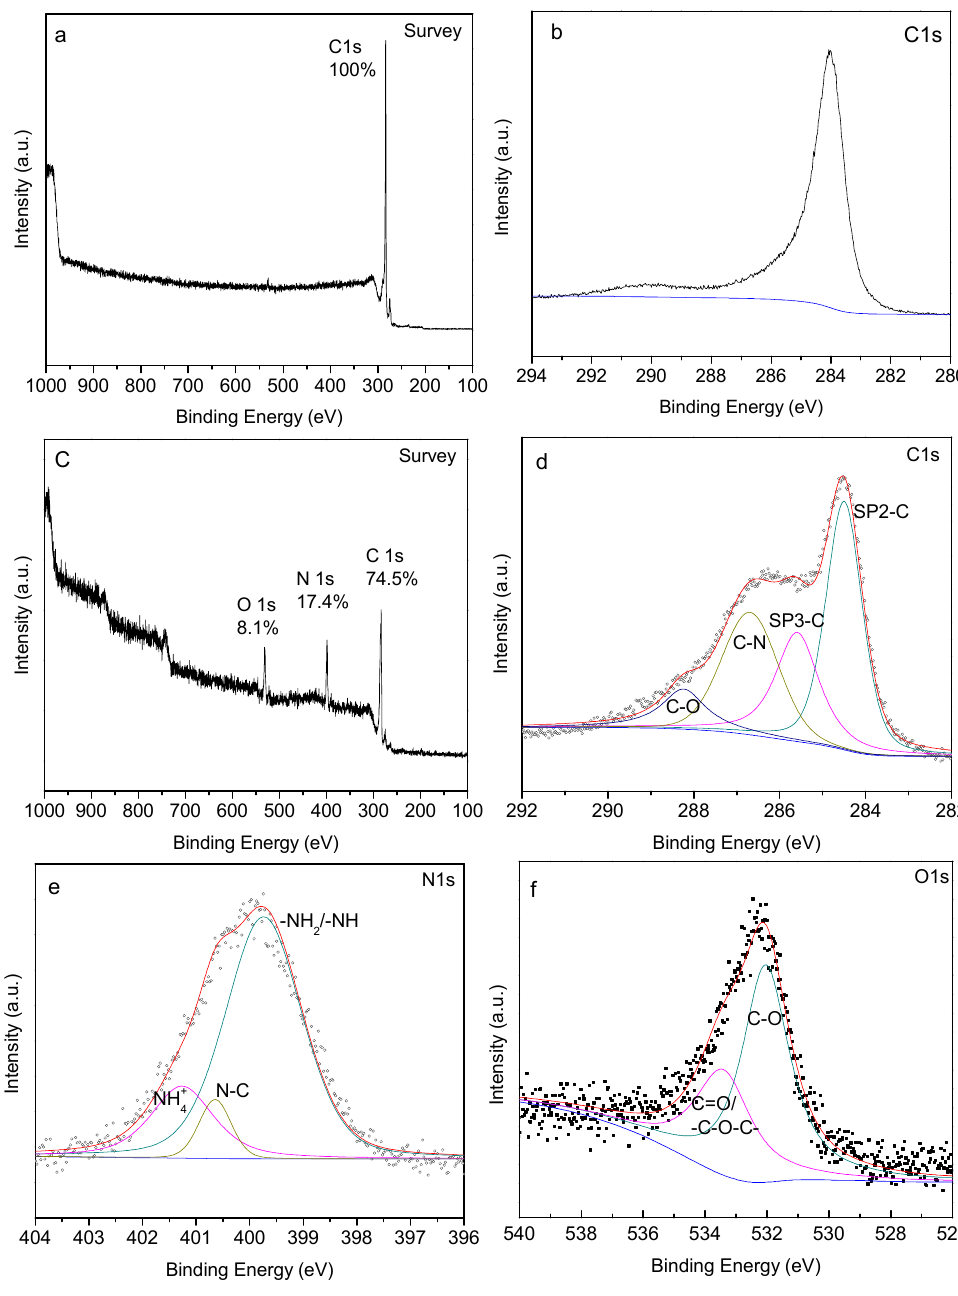
Figure 6. XP spectra of MWCNTs, ( a ) pristine survey; ( b ) pristine C1s region and EDA plasma ‐ functionalized CNT; ( c ) survey; ( d ) C1s region; ( e ) N1s region; and ( f ) O1s region.